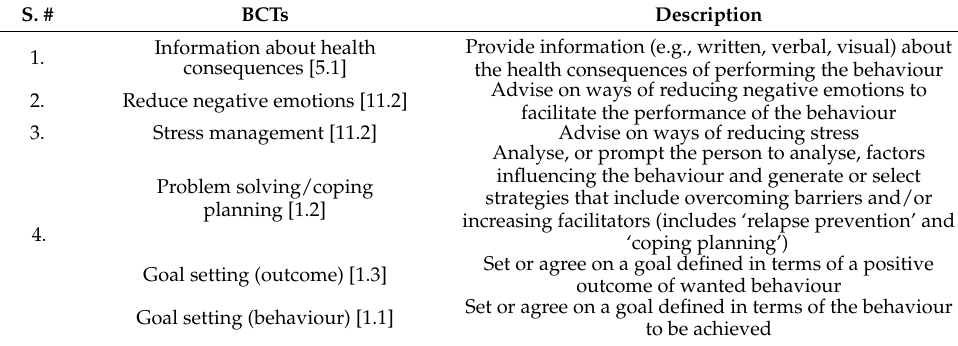
Table 1. Relevant coded interventions and their